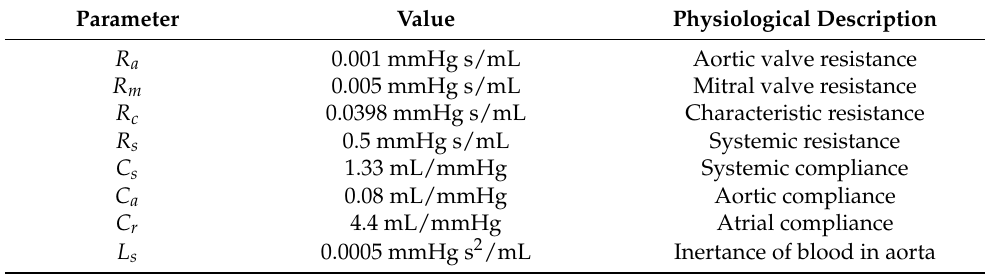
Table 3. Circulation